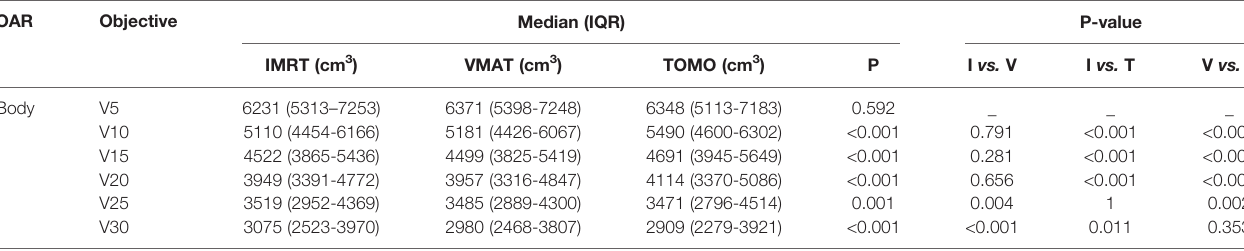
TABLE 4 | Low-dose radiation volume of IMRT, VMAT and TOMO in 40 NPC patients.